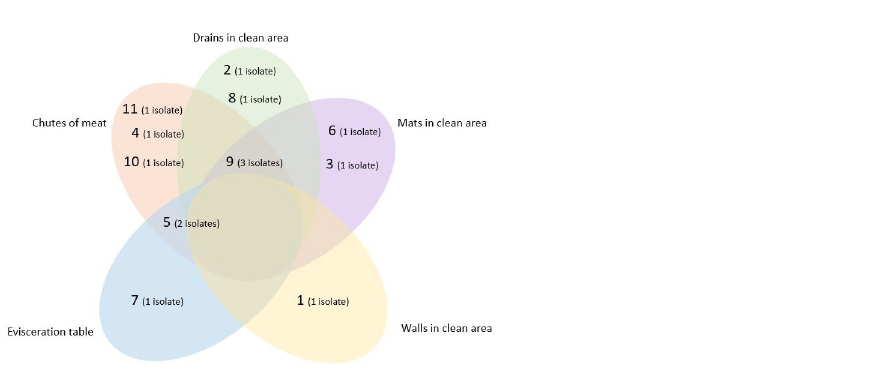
Fig 2. Sample collection points of the 11 L . monocytogenes pulsotypes detected in poultry slaughterhouses A, B and C located in Federal District and Goia´s. The numbers in parenthesis represent the number of isolates belonging to each pulsotype, totaling 14